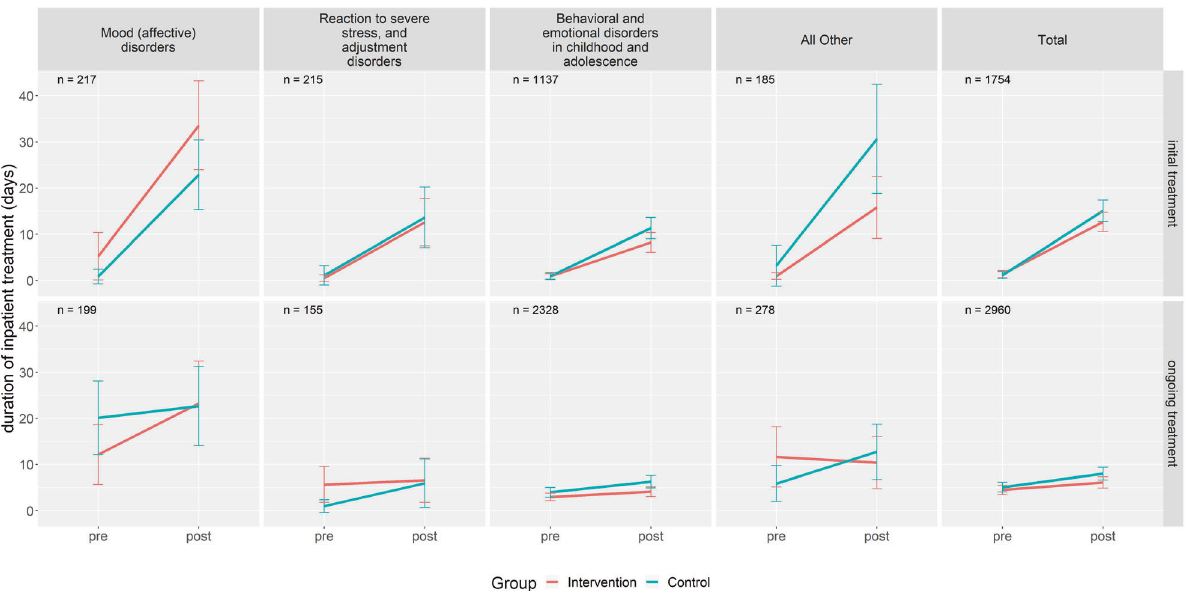
Fig. 3 Mean duration of inpatient treatment in different clusters of psychiatric disorders (children and adolescent psychiatry). Intervention = FIT hospital, Control = hospital employing routine care; pre = 1 year prior to inclusion; post = 1 year after inclusion; Initial treatment = patients that had no contact to the psychiatric ward or PIA in the corresponding FIT or control hospital in the 2 years prior to being included into the study; Ongoing treatment = patients having at least one contact to the psychiatric ward or PIA in the corresponding FIT or control hospital in the 2 years prior to being included into the